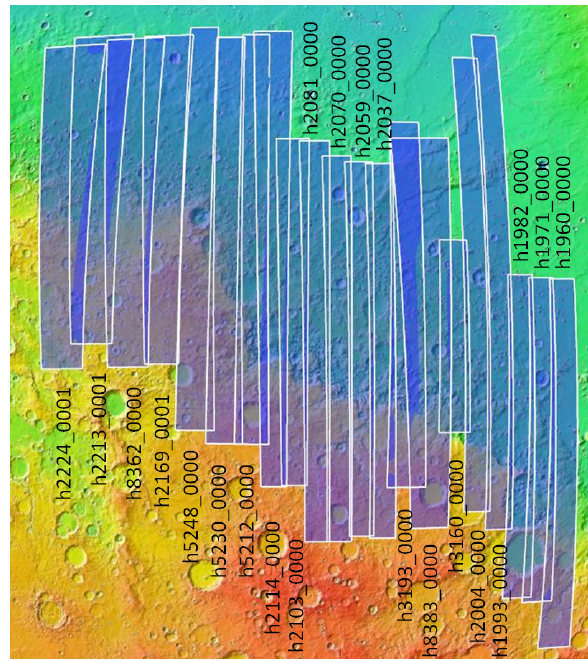
Figure 6: Color coded MOLA DTM with footprints of 21 HRSC nadir channel images constituting a photogrammetric